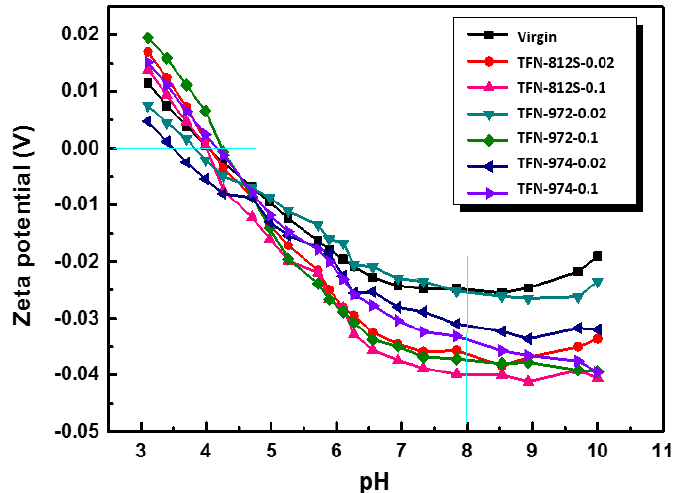
Figure 11. Zeta potentials of the membranes with different concentrations and types of NPs.